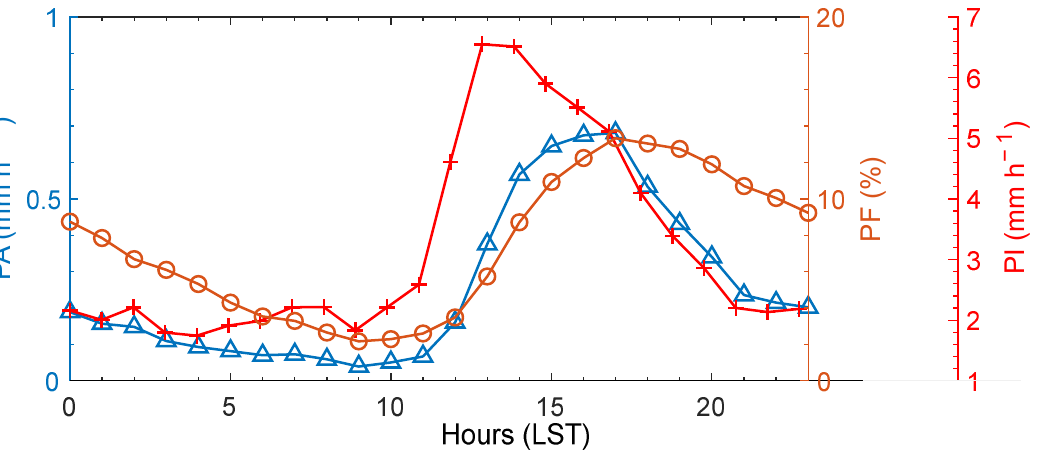
Figure 4. Climatology of diurnal variations of PA (blue), PF (merigold), and PI (red) at Kototabang during